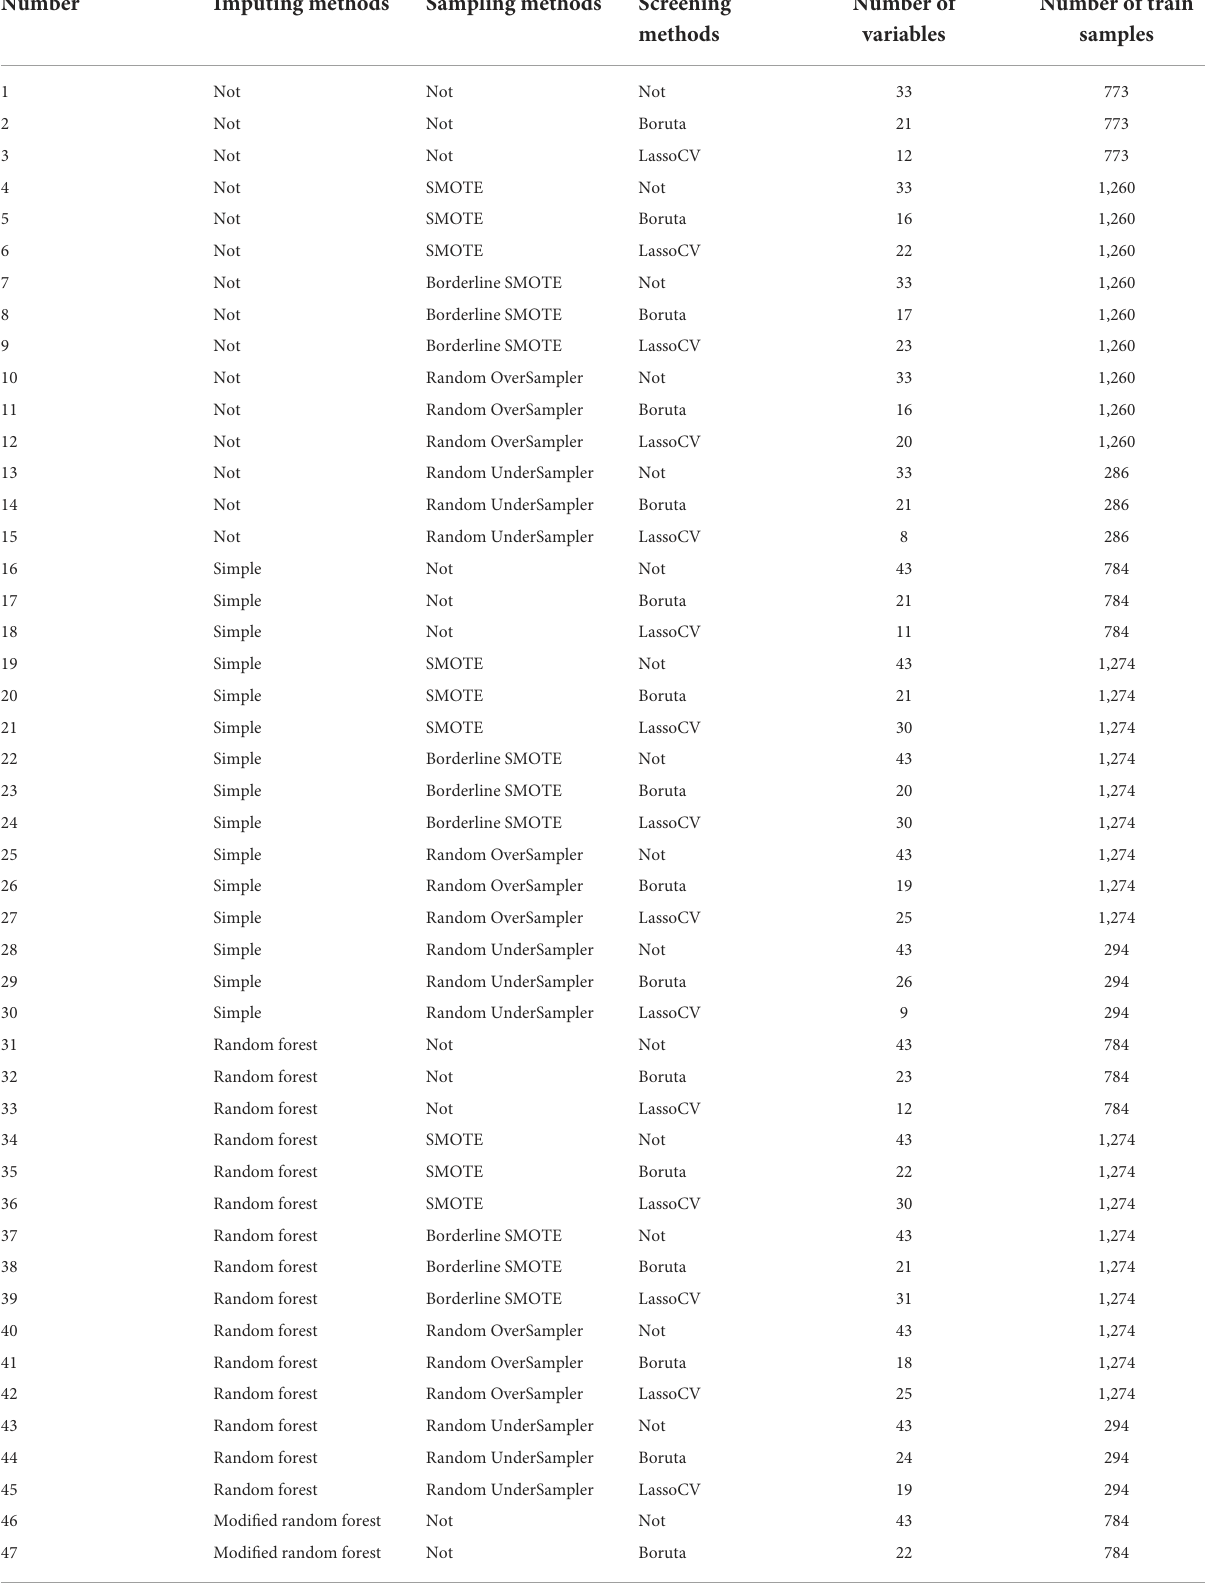
TABLE 2 The detailed information of 60